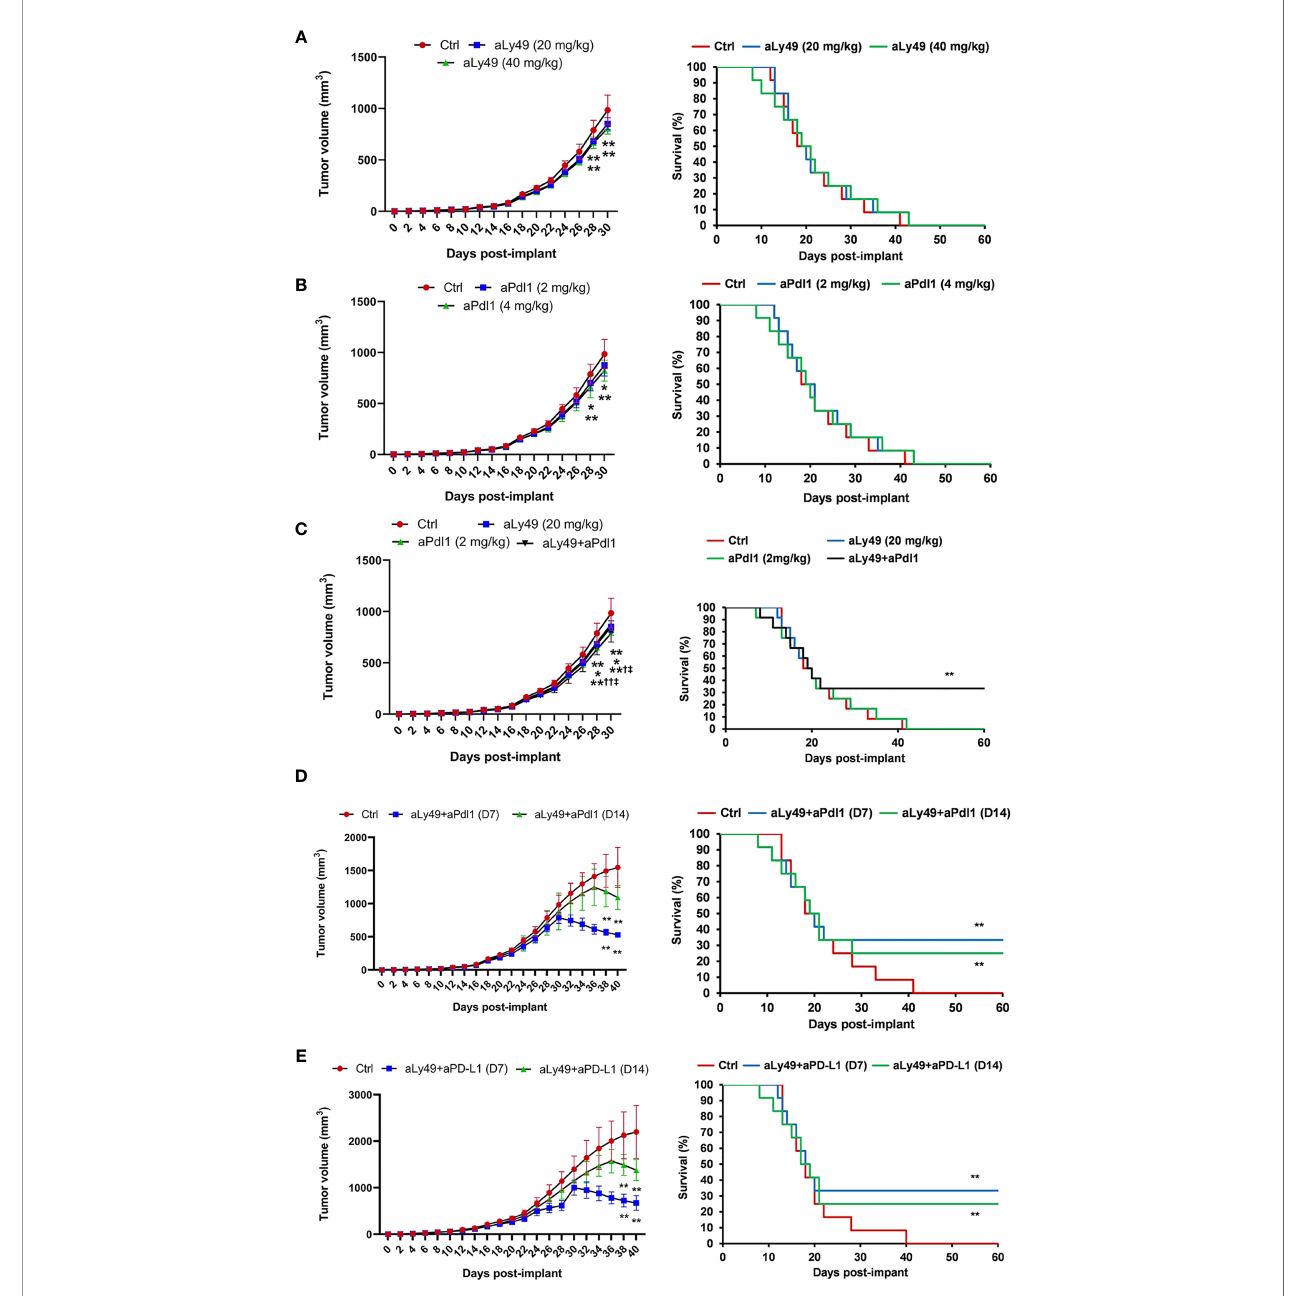
FIGURE 2 | Lirilumab and Avelumab Enhance Anti-Tumor Activity in vivo . (A) Tumor-bearing mice administered IgG (control), aLy49 (20 mg/kg daily), or aLy49 (40 mg/kg daily) intraperitoneally (i.p.) seven days (D7) after HPV+ U14 cervical tumor cell implantation. (B) Tumor-bearing mice administered IgG (control), aPdl1 (2 mg/ kg daily), or aPdl1 (4 mg/kg daily) i.p. seven days after HPV+ U14 cell implantation. (C) aLy49 (20 mg/kg daily) plus aPdl1 (2 mg/kg daily) starting on D7. (D) Tumor- bearing mice administered IgG (control) or aLy49 (20 mg/kg daily) plus aPdl1 (2 mg/kg daily) i.p. starting at D14. (E) Tumor-bearing mice were administered IgG (control) or aLy49 (20 mg/kg daily) plus aPdl1 (2 mg/kg daily) i.p. starting at D7 or D14. *P < 0.05, **P < 0.01 versus control group, † P < 0.05, †† P < 0.01 versus aLy49 group, ‡ P < 0.05 versus aPdl1 group [(left) one-way ANOVA or (right) log-rank test]. n= 12 mice per